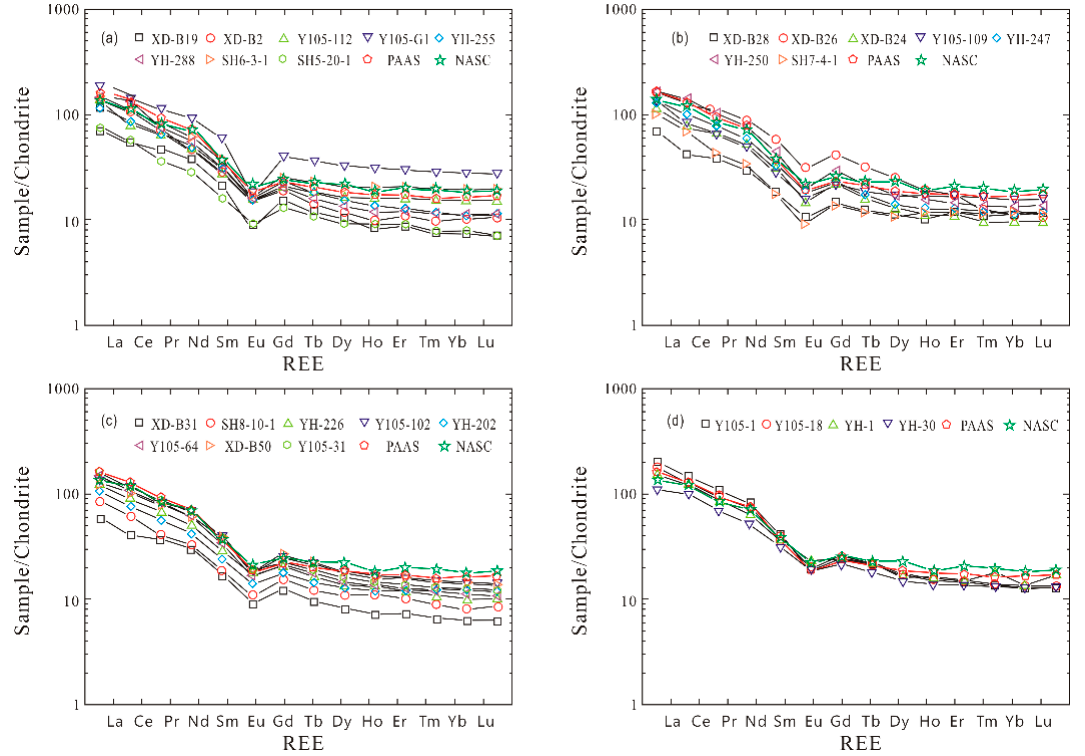
Figure 11. Chondrite-normalized rare-earth-element (REE) patterns in sedimentary rocks of the Wufeng–Longmaxi shale in the Yangtze Platform, South China. Chondrites values are from [51]. ( a ) The Wufeng Formation; ( b ) the Guanyingqiao bed; ( c ) the Long 11 member of the Longmaxi Formation; ( d ) the Long 12 of the Longmaxi Formation.